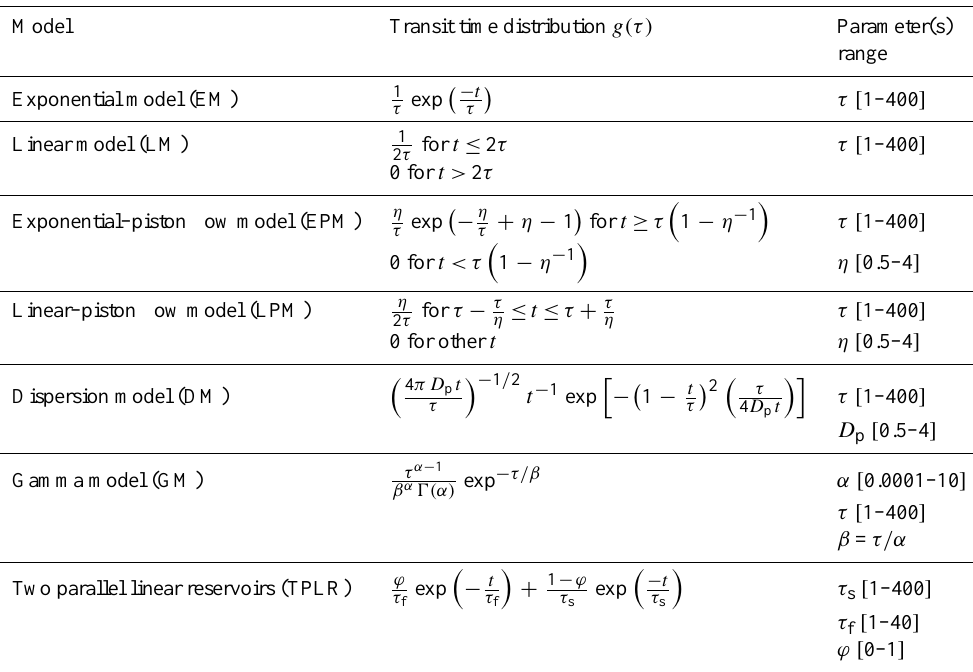
Table 3. Lumped-parameter models used for estimation of mean transit times and transit time distribution functions of water in the San Francisco